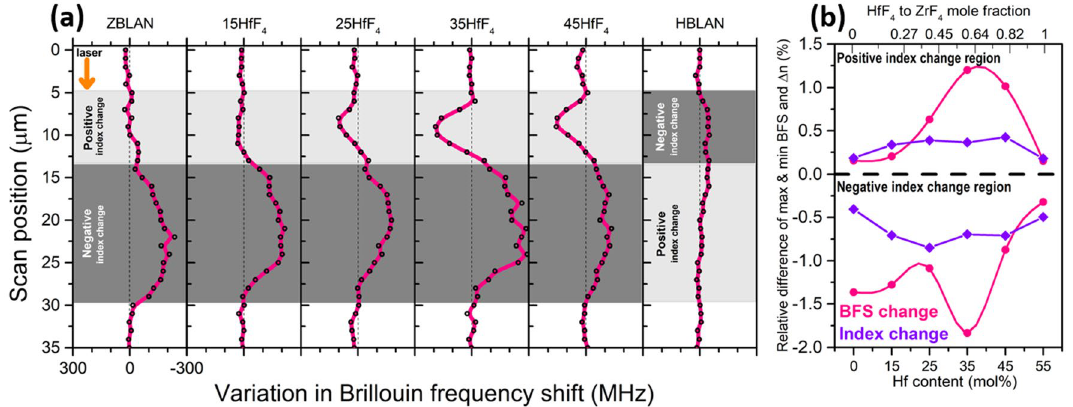
Figure 8. ( a ) Brillouin frequency shift line scans of waveguides written in all compositions at 5 kHz, 500 nJ, 0.04 mm/s and focusing objective collar set at 1000 μm. ( b ) A comparison of relative difference observed between the maximum and minimum values of Brillouin frequency shift and the refractive index change measured in the same